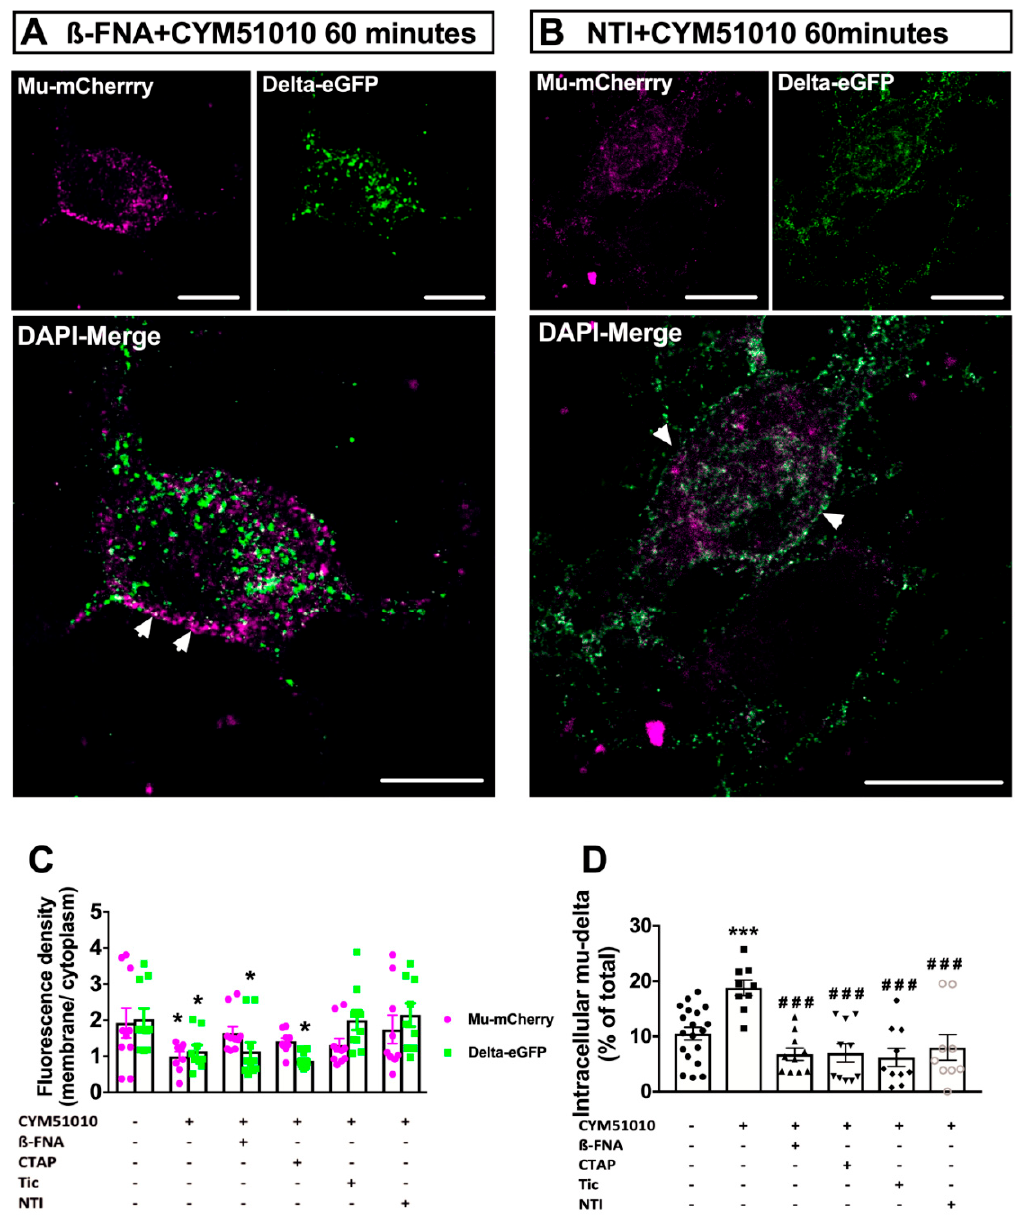
Figure 4. Antagonist pretreatment abolishes mu–delta opioid receptor co-internalization by CYM51010 in primary hippocampal cultures. ( A ) Representative confocal images showing mu-mCherry predominant localization at the plasma membrane and delta-eGFP extensive internalization after pretreatment with the mu antagonist β -FNA (200 nM) for 15 min, followed by incubation for 60 min with CYM51010 (400